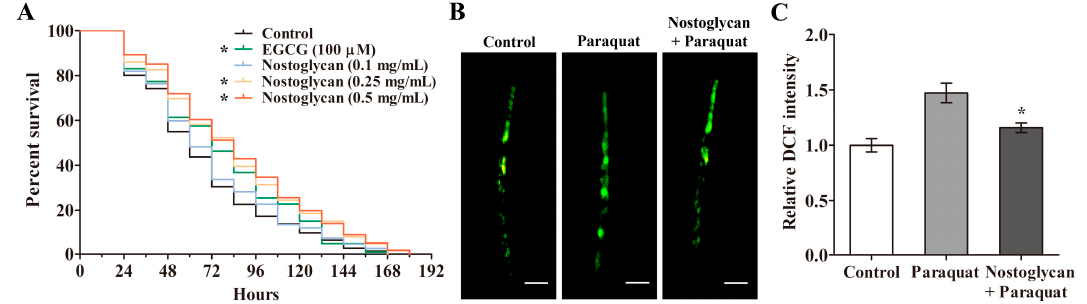
Figure 3. Effect of nostoglycan on the survival rate and ROS level of C. elegans under oxidative stress. ( A ) Oxidative survival curves of nematodes with or without nostoglycan treatment. Young adult nematodes were first treated with nostoglycan or EGCG at the indicated concentrations and then exposed to 70 mM paraquat. Live nematodes were scored every 12 h until all dead. Representative Kaplan–Meier curves are presented from three independent experiments; ( B ) Representative micrographs of DCF fluorescence in paraquat-exposed nematodes. The nematodes were treated with or without 0.5 mg/mL nostoglycan prior to 10 mM paraquat exposure and then stained with the fluorescent probe DCFH-DA. The fluorescent images were captured by an ImageXpress Micro System. Scale bars, 200 μ m; ( C ) DCF fluorescence intensity of paraquat-exposed nematodes. The nematodes were treated as in ( B ), and the DCF intensity was measured with a fluorescence microplate reader after DCFH-DA treatment. Data are presented as mean ± SEM of three independent experiments. * p < 0.05 (as compared to paraquat-exposed nematodes).